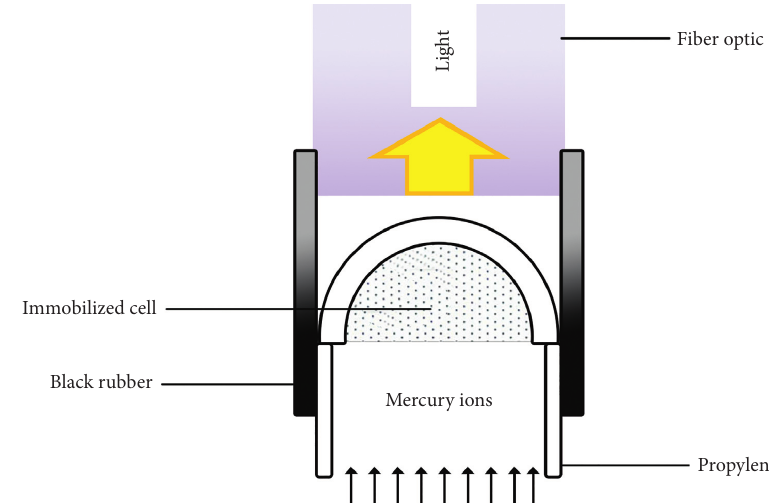
Figure 4: Schematic of the biosensor